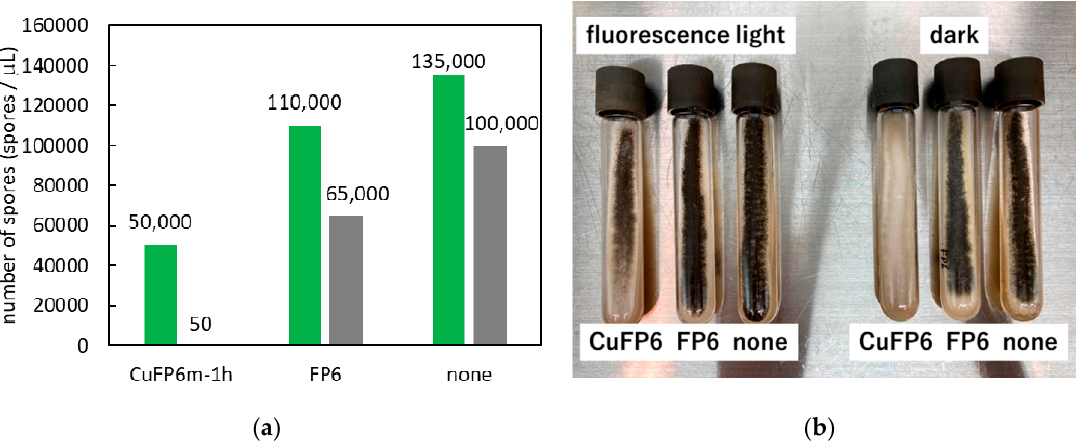
Figure 8. Sporulation tests: ( a ) number of spores after 3-day growth of A. niger under florescence light (green bars) and in the dark (grey bars); and ( b ) representative photographs of slants for CuFP6m-1h, FP6 and in the absence of photocatalyst.